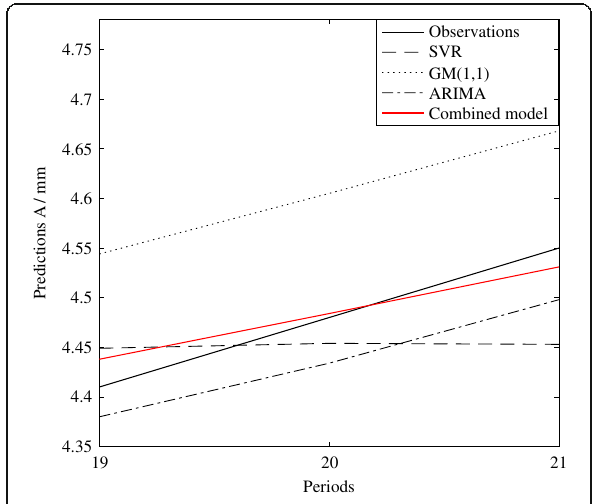
Fig. 3 Predictions A of each model. Selecting the SVR, GM (1,1), ARIMA as the basic models, predictive value A is predicted by three single models with original fitting data. According to the predictions A of the single model and combined model, and the observations, we connect the respective values through the broken line, which can form the most direct